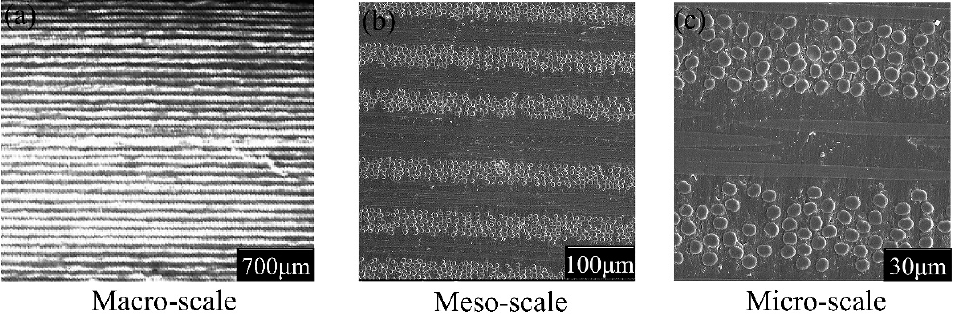
Figure 4. Sample A morphology before testing (( a ) Macroscopic section morphology, ( b ) Mesoscopic section morphology, and ( c ) Microscopic section morphology).